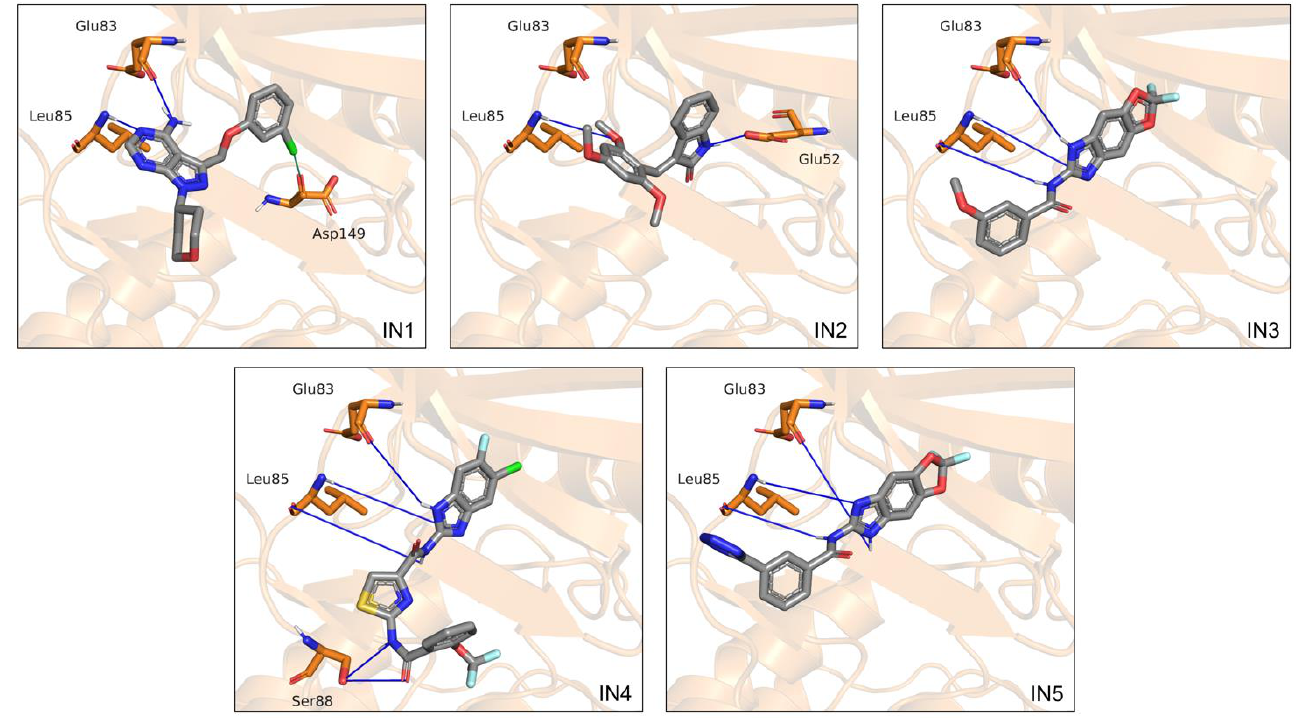
Figure 2. Binding modes calculated by molecular docking for the five inhibitors analyzed. Cartoon representation of CK1ε with residues Glu52, Glu83, and Leu85, and Ser88 on licorice model. Hydrogen bonds are shown as blue lines.